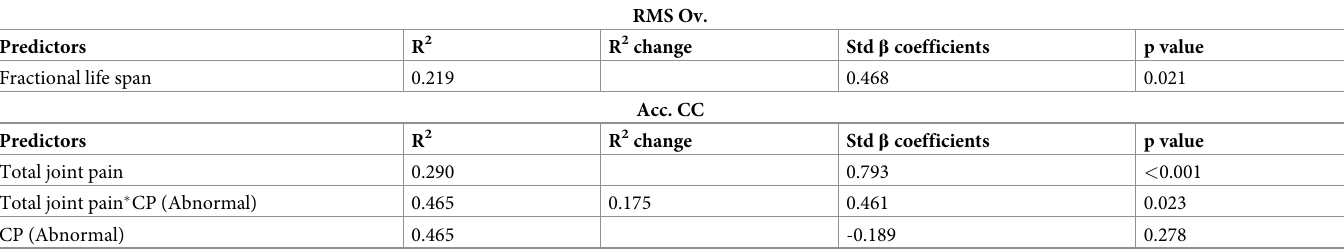
Table 6. Stepwise regression model for RMS Ov and Acc CC.